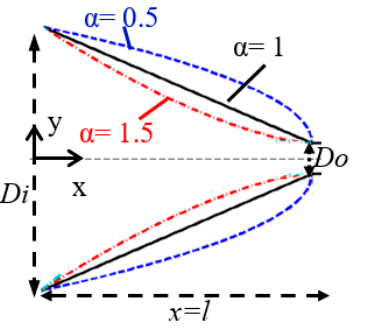
Figure 3. Various taper shapes for different values of 𝛼 . The corresponding shape of taper for 𝛼 = 0.5, 1 and 1.5 is convex, linear and concave, respectively. α = 0.5, 1 and 1.5 is convex, linear and concave,